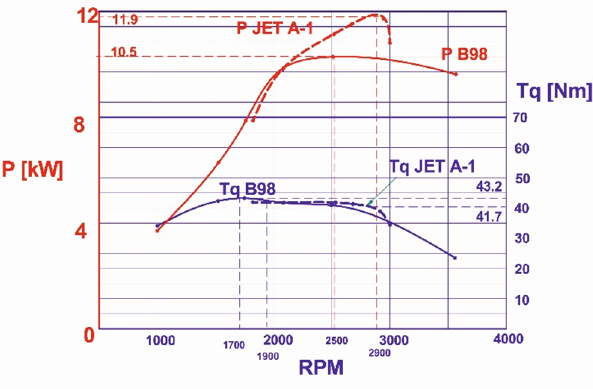
Fig. 6. Comparison of characteristics of a prototype engine powered by JET-A1 fuel and EuroSuper 98